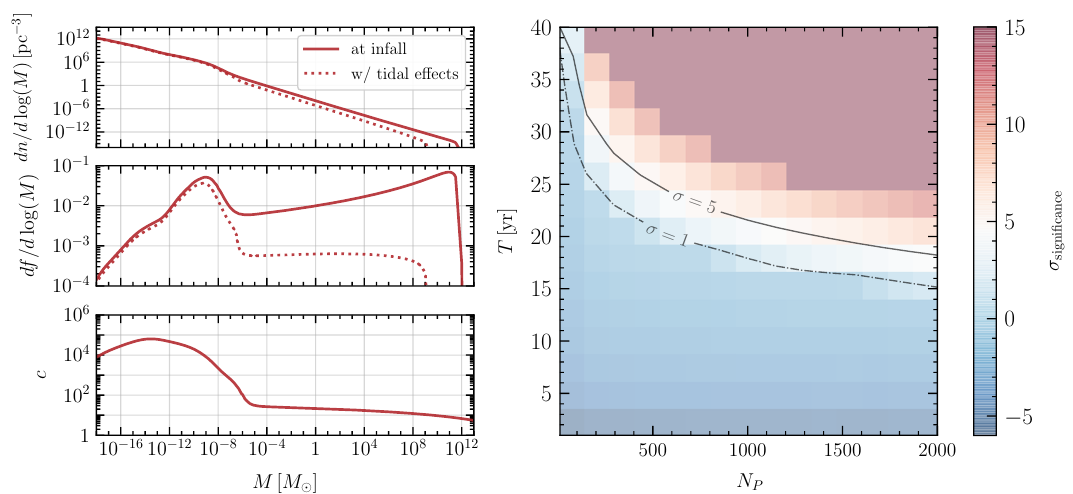
Figure 7 . Left : sHMF (top panel), and mass fraction per logaritmich interval (center panel) before (solid) and after (dashed) the inclusion of tidal effects. The lower panel shows the typical subhalo concentration parameter as a function of their mass. Right : discovery significance for different values of the observation time and number of pulsars in the array. The residual timing noise and observation cadence have being fixed to t = 10 ns and ∆ t = 1 week . The dashed and solid lines rms show the 1 and 5 -sigma significance contours